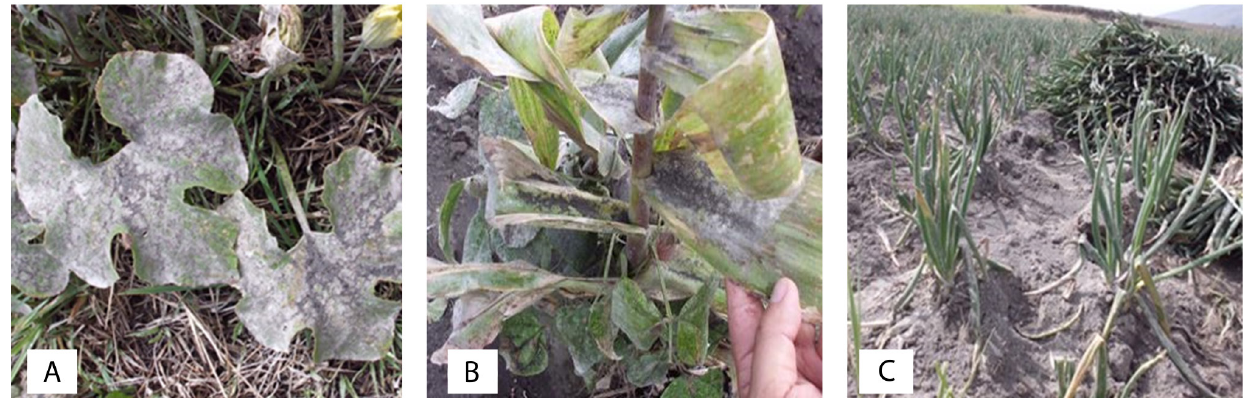
Figure 5: Influence of leaf shape and leaf angle on tephra retention on foliage for three crop plants found in the study area: black seed squash; multilobed and horizontal leaves [A]; corn; linear blades in upright position [B]; white onion; corn; linear blades in the upright position